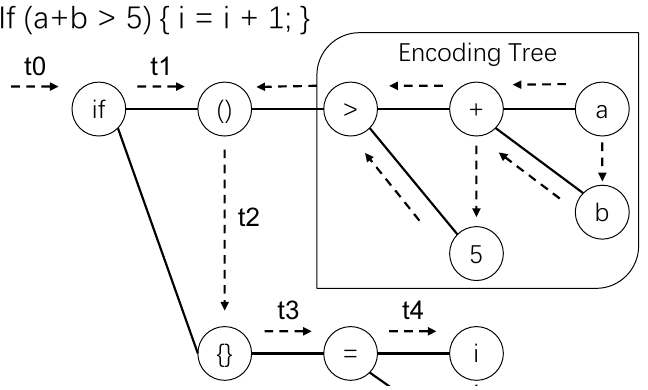
Figure 2. Insights of the Hierarchical Language